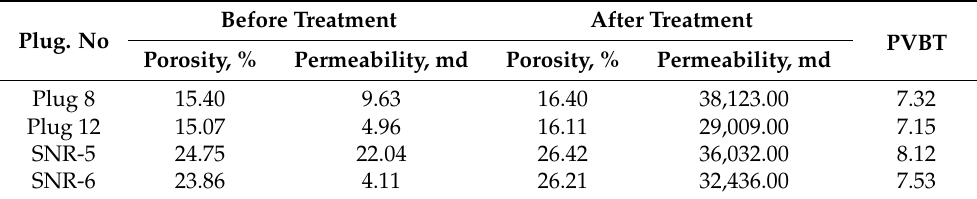
Table 4. Characteristics of limestone core samples before and after CO 2 foamed acid injection.